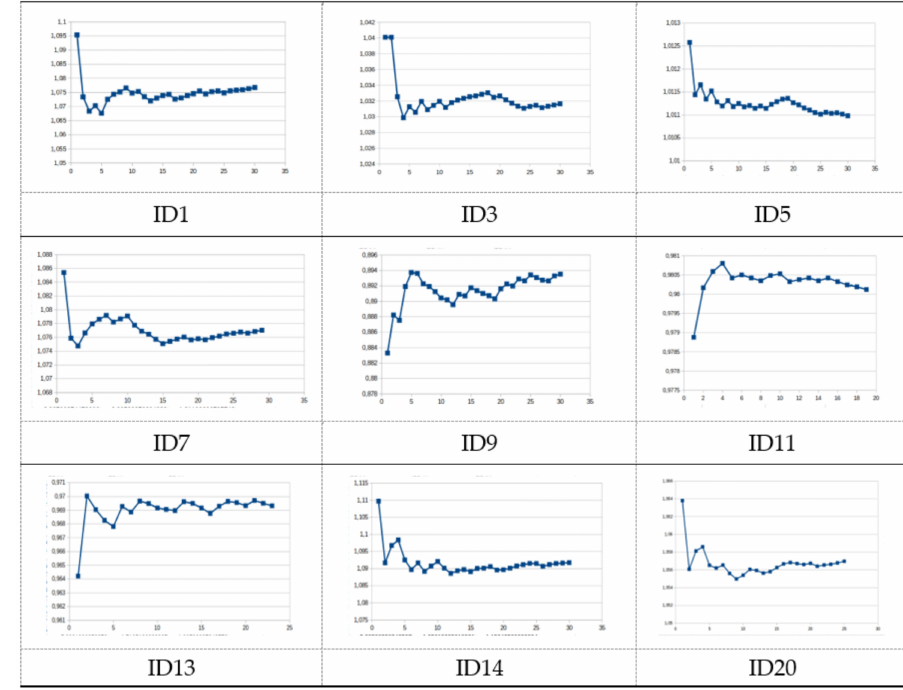
Figure 7. EI/ER evolution for some Tests (1, 3, 5, 7, 9, 11, 13, 14,